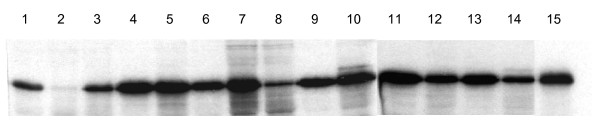
Assessment of the strength of T. maritima strong promoter candidates in a cell-free system. Lanes 1 – Ptac (reference); 2 – PTM0032; 3 – PTM0373; 4 – PTM0477; 5 – PTM1016; 6 – PTM1067; 7 – PTM1271; 8 – PTM1272; 9 – PTM1429; 10 – PTM1490; 11 – PTM1667; 12 – PTM1780; 13 – PTMt45; 14 – PTMt11; 15 – PargC. Similar results were obtained in 3 experiments.